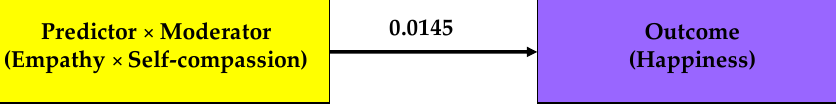
8 of 15 Figure 3. Conceptual model of self-compassion moderation. Table 3. Self-Compassion as a moderator between empathy and happiness ( N = 566).